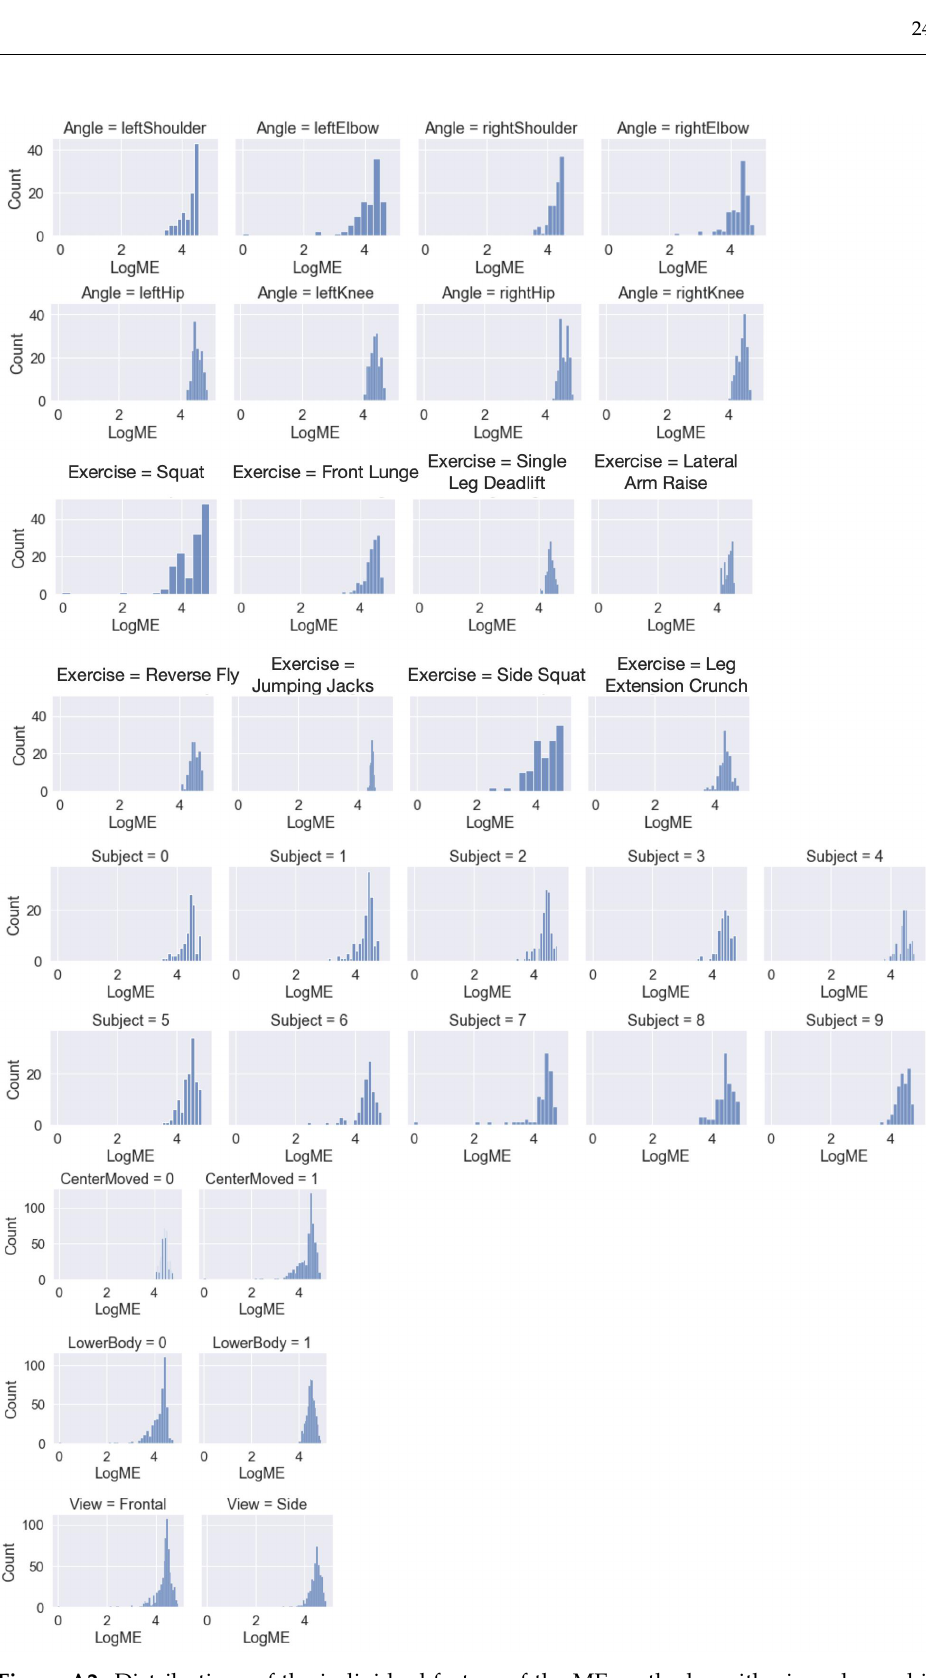
Figure A2. Distributions of the individual factors of the ME on the logarithmic scale used in the Welch ANOVA analysis. All of the factors show a distribution which is sufficiently close to a normal distribution so that an ANOVA analysis should be